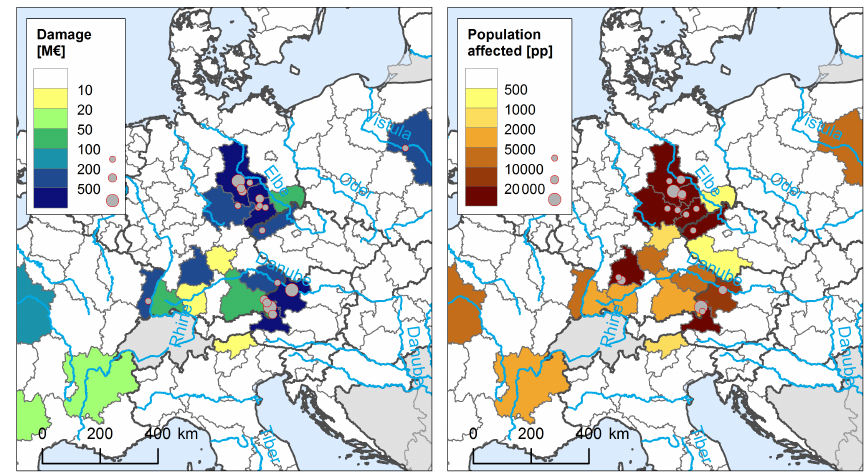
Figure 6. Estimates of damage and population affected (event-based method) in central Europe from 25 May to 10 June 2013. Grey circles indicate hotspots of simulated damage larger than EUR100million and population affected in excess of 5000. Areas outside the simulation domain are masked in